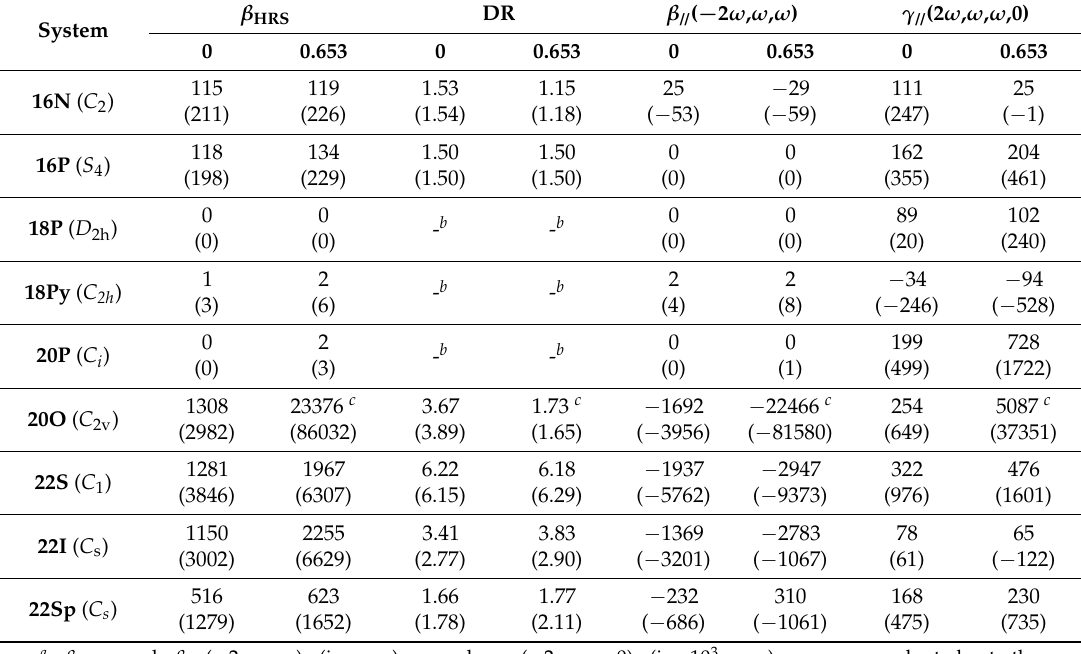
Table 8. Hyper-Rayleigh scattering (HRS) first hyperpolarizability characteristics ( β HRS ) and depolarization ratio (DR), longitudinal (//) component and second hyperpolarizability ( β // of unsubstituted Hückel porphyrinoids a